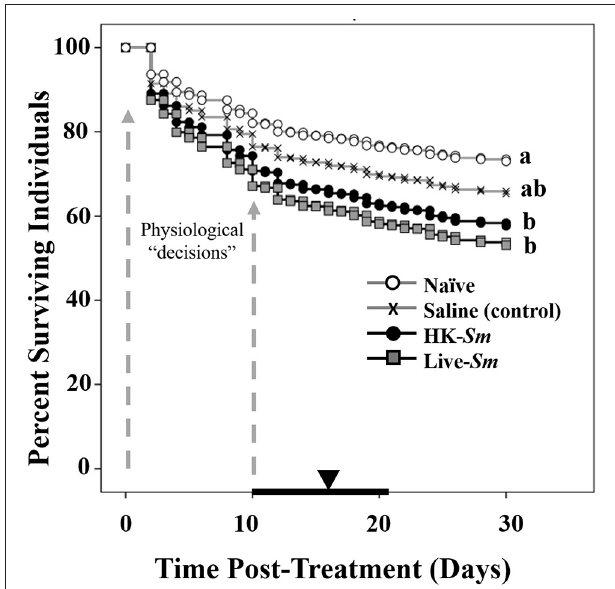
FIGURE 3 | Survival curves generated from the Cox proportional regression analysis. Dotted gray arrows denote the time interval in which there was the steepest decline in survival. This time preceded the period in which reproductives were likely forced to make physiological “decisions” between immunity and reproduction. The mean (inverted triangle) and interquartile range of the onset of oviposition (bold black line) for surviving colonies are overlaid on the X-axis. Letters to the right of each survival curve represent significant differences following a Bonferonni correction.